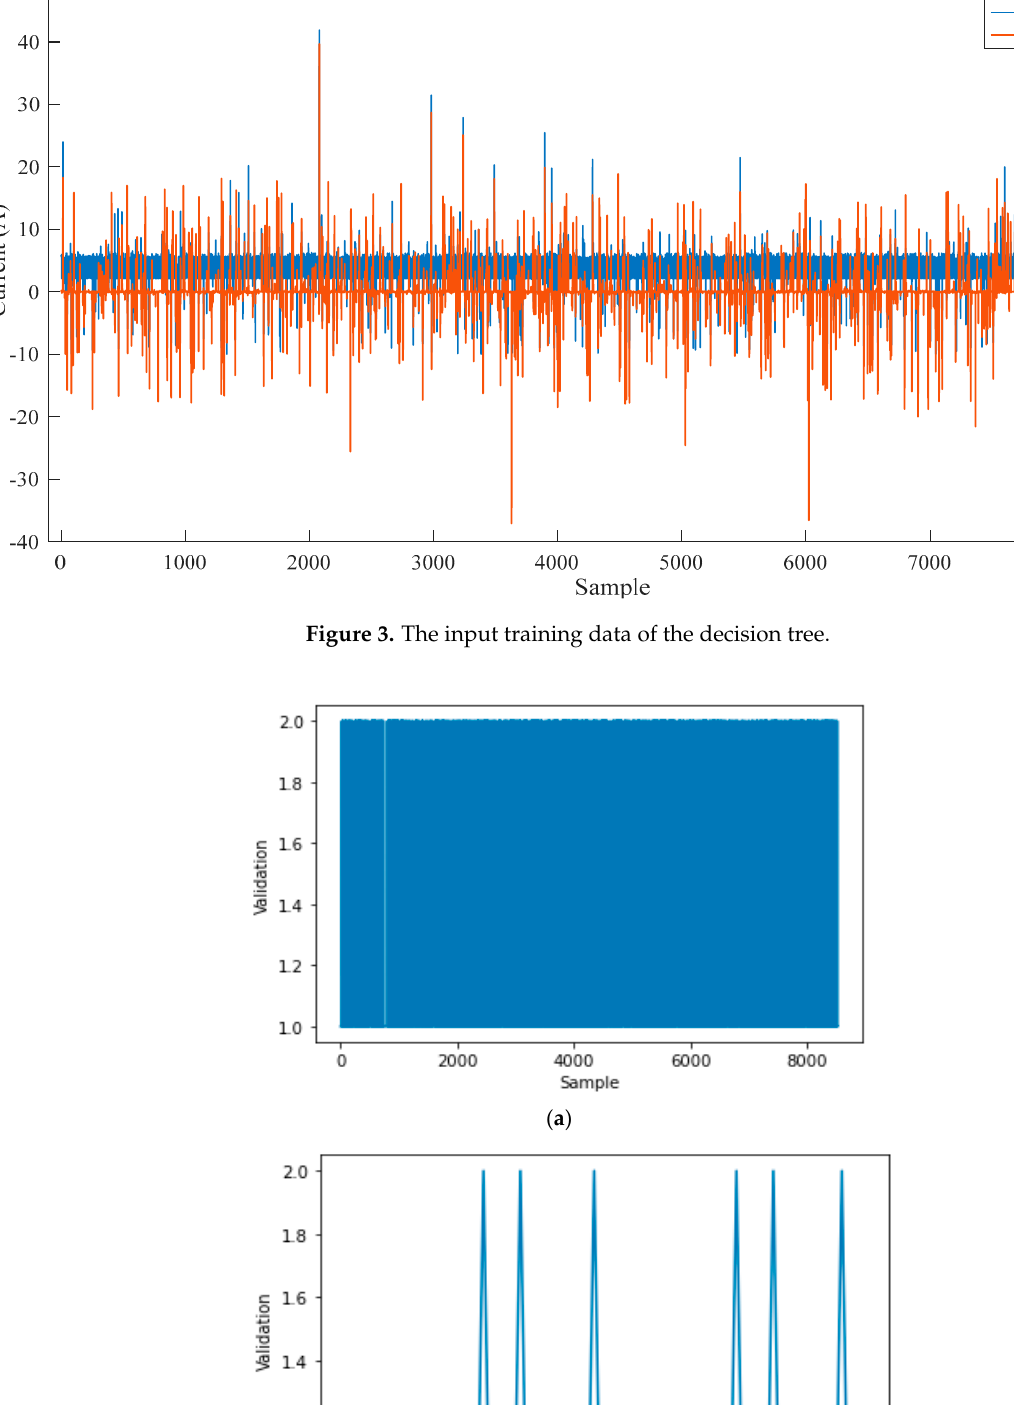
Figure 5. The input testing data of the decision tree. ( a )